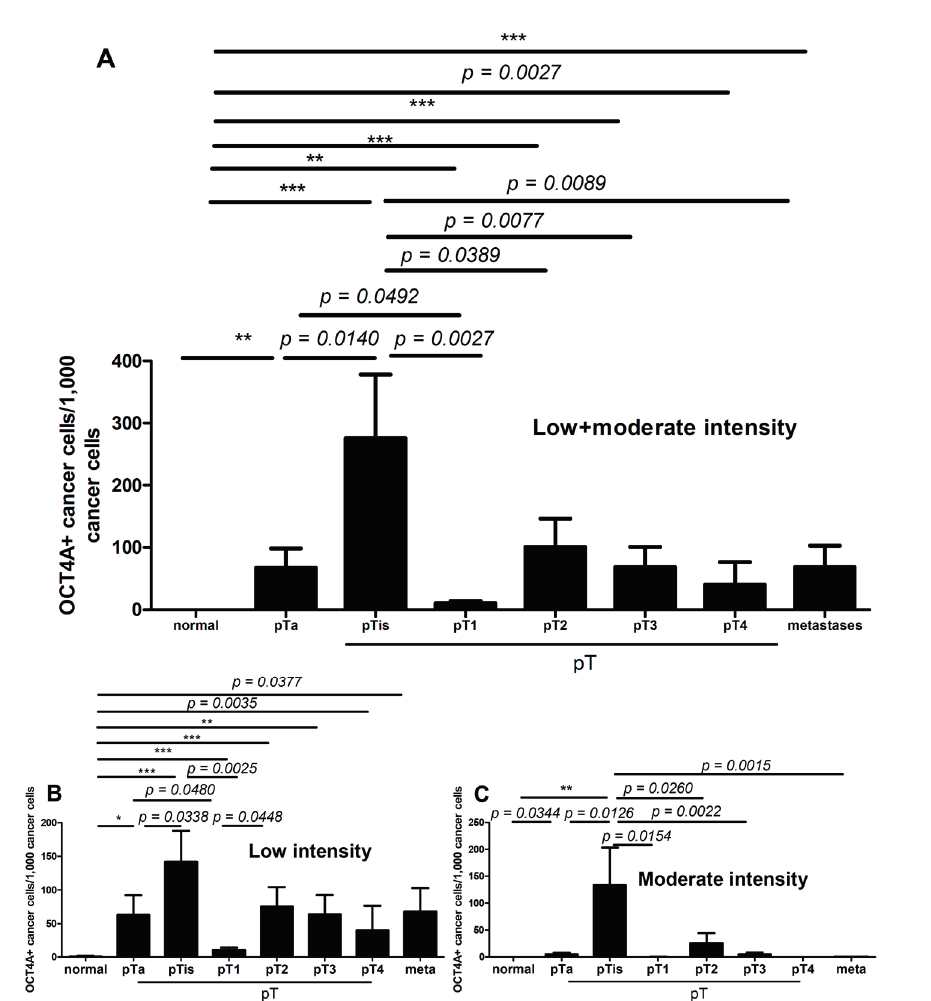
Figure 2. The mean ( A ) percentage of cells with low and moderate level of OCT4A in normal epithelium, primary tumors and metastases; The low ( B ) and moderate ( C ) mean expression of OCT4A in normal epithelium, primary tumors and metastases. Significant differences are denoted by p -values ( t -test) and as * p < 0.05, ** p < 0.01, *** p < 0.001 by